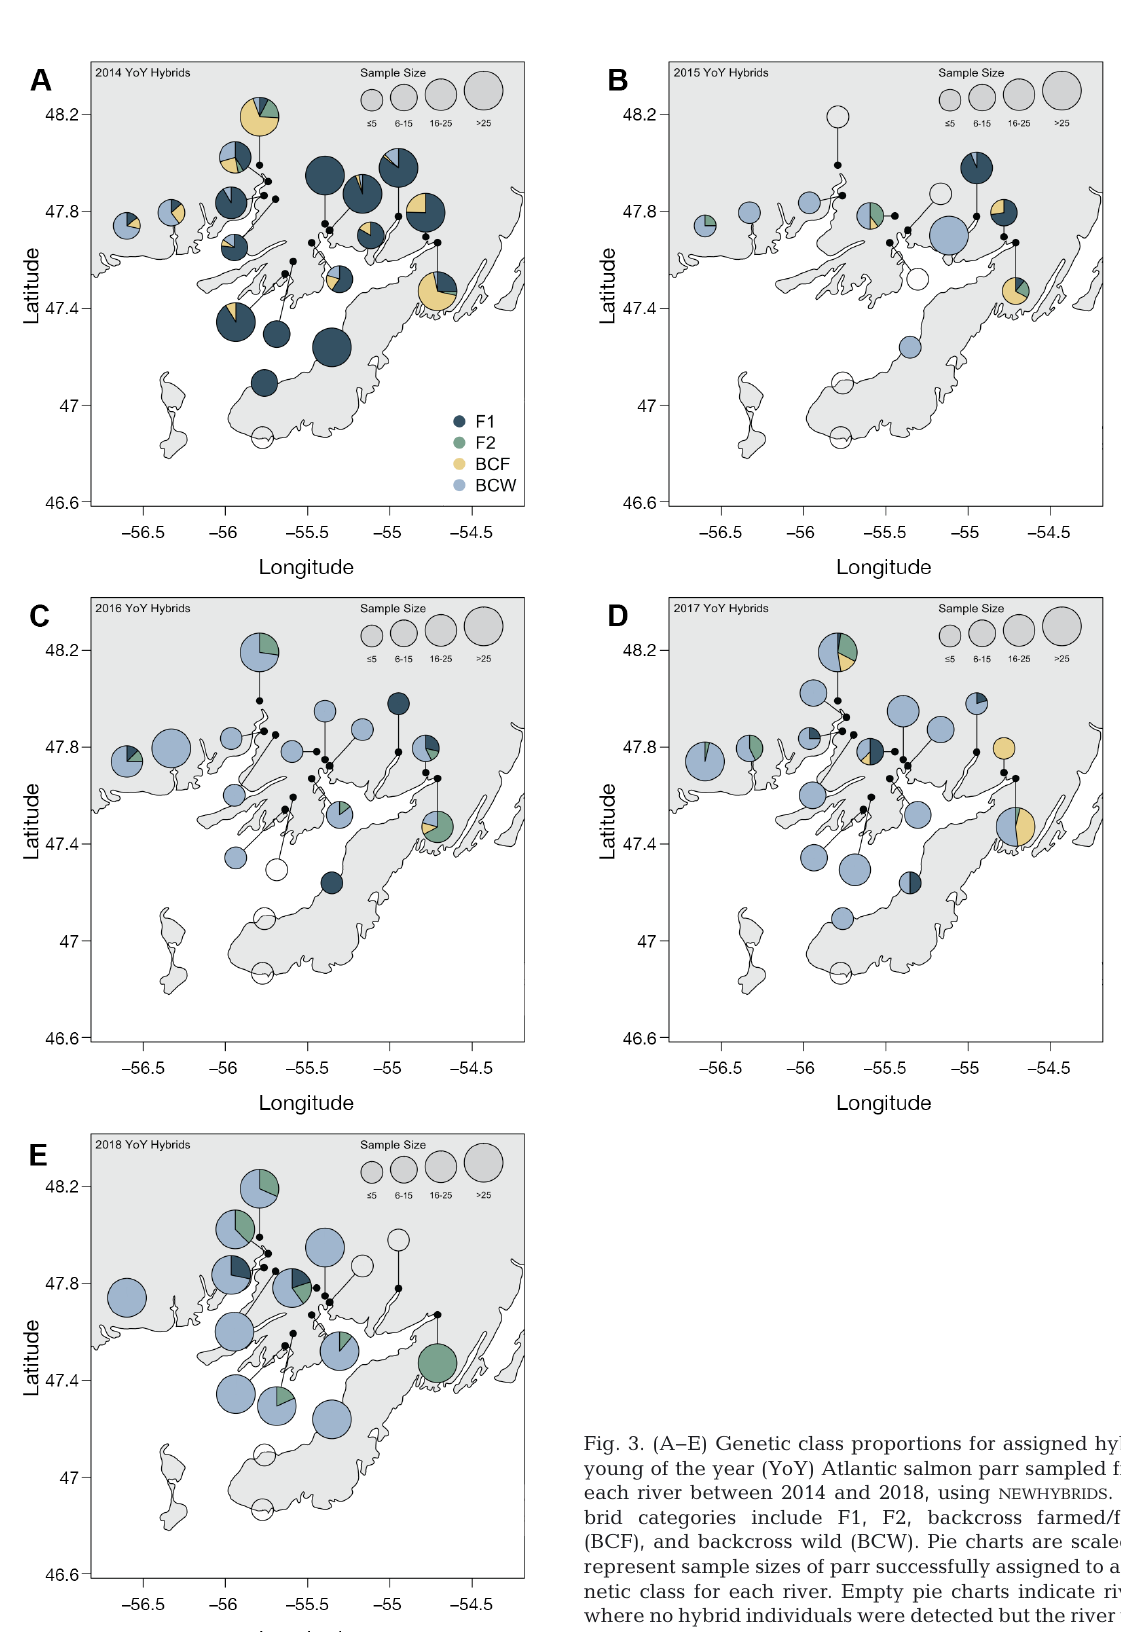
Fig. 3. (A−E) Genetic class proportions for assigned hybrid young of the year (YoY) Atlantic salmon parr sampled from each river between 2014 and 2018, using NEWHYBRIDS . Hy- brid categories include F1, F2, backcross farmed/feral (BCF), and backcross wild (BCW). Pie charts are scaled to represent sample sizes of parr successfully assigned to a ge- netic class for each river. Empty pie charts indicate rivers where no hybrid individuals were detected but the river was sampled in that